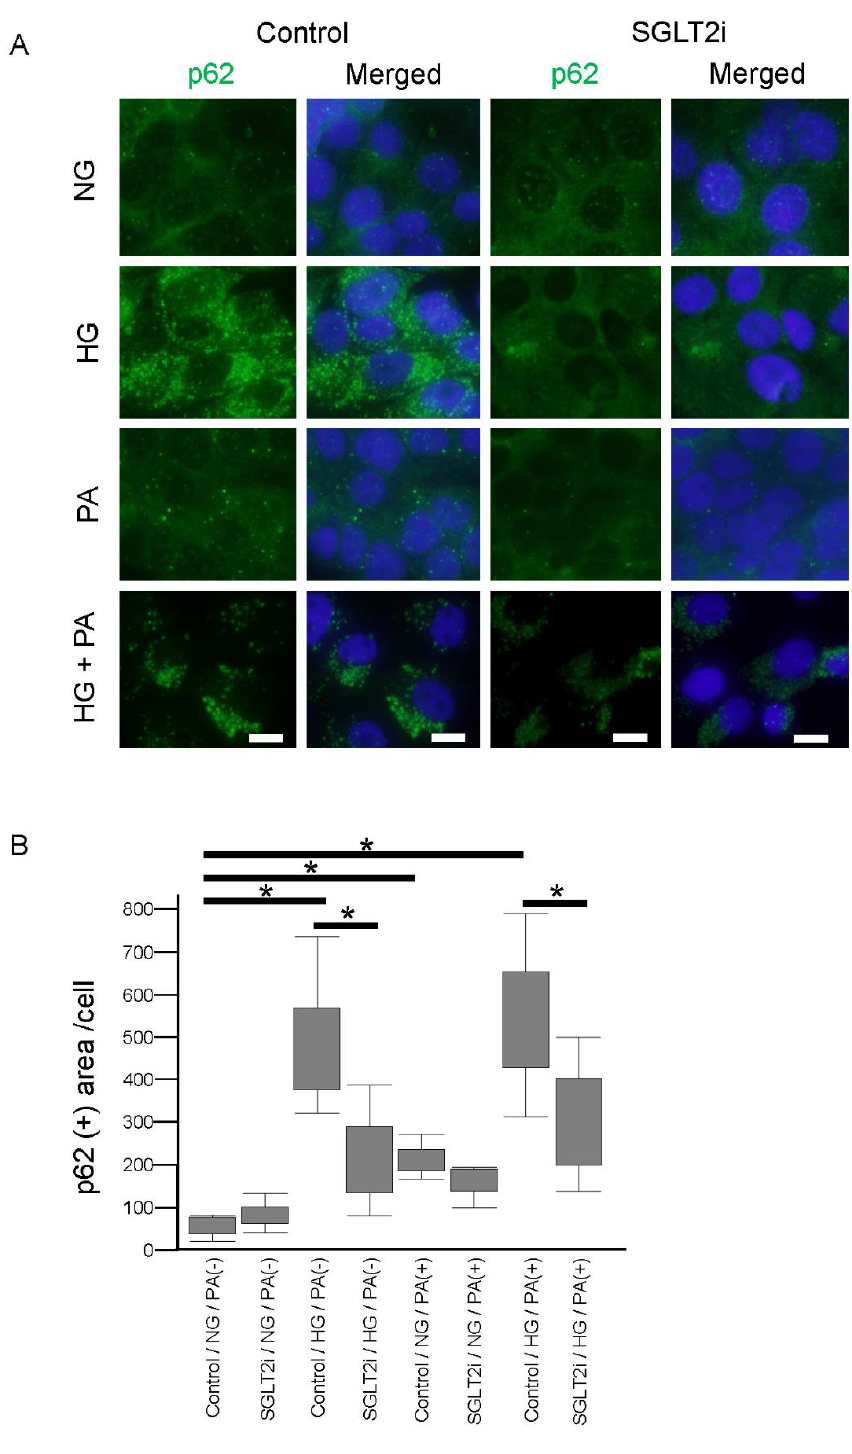
Figure 4. SGLT2 inhibitor (SGLT2i) decreased p62 accumulation on LLC-PK1 cells ( A ) Immunofluorescence analysis for p62 accumulation. ( B ) Quantitative analysis of p62-positive area per cell. Results are presented as the mean ± standard deviation. Differences were evaluated by two-way ANOVA followed by Tukey–Kramer test (* p < 0.05); bars: 10 µm (normal glucose: NG, high glucose: HG, palmitic acid: PA). SGLT2i: empagliflozin. These results suggest that SGLT2i promoted the degradation of p62 accumulation mainly via protecting PTCs from high glucose exposure.